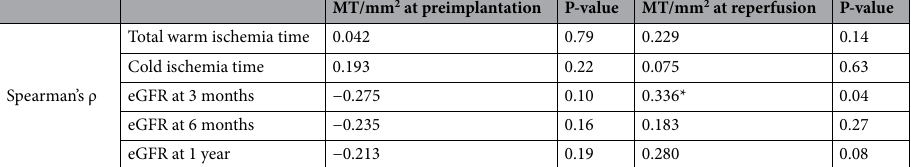
Table 3. Spearman correlations of ischemia times and kidney function and microthrombi development. *p <